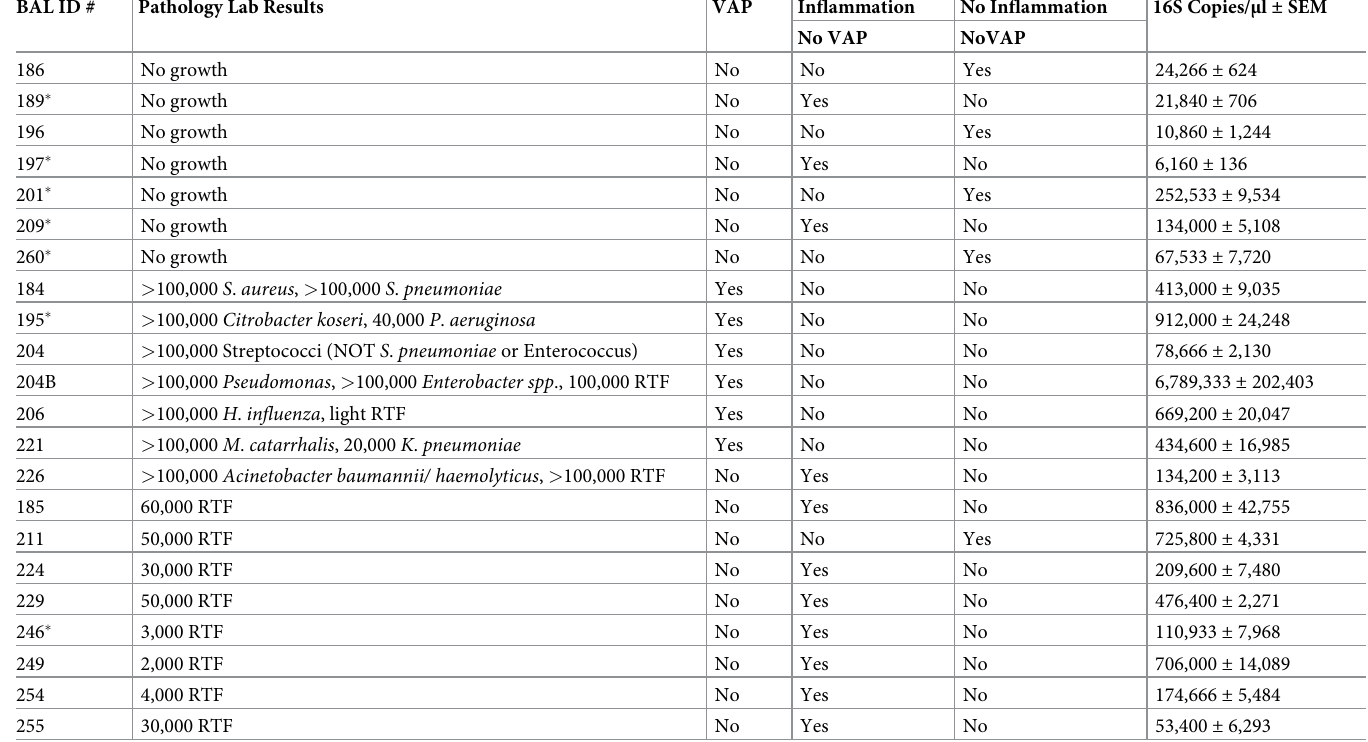
Table 2. Quantification of 16S copies in culture-negative, culture-positive, and respiratory tract flora (RTF) for bronchoalveolar lavage (BAL) samples. Patients who were on antibiotics at the time of BAL are denoted with an asterisk next to BAL ID #. Pathology results are the results of BAL which were used for treatment clinically. Copy number of 16S is denoted at copies per microliter +/- standard error of the mean